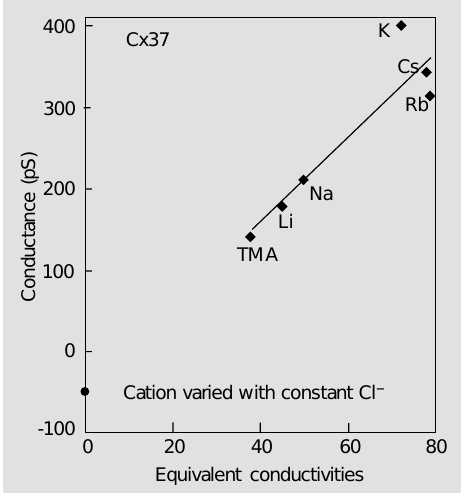
Figure 2 - Measured unitary con- ductance for Cx37 with various cations, with Cl - again remain- ing constant. The data indicate that the Cl - conductance is a negative number. This illustrates that the analytical approach used has limits. It implies that chan- nel ion interactions could play a role in determining the nature of the permselectivity and that dif- ferent ionic conditions will yield different permeation rates for the same ion. TMA, Tetramethyl-